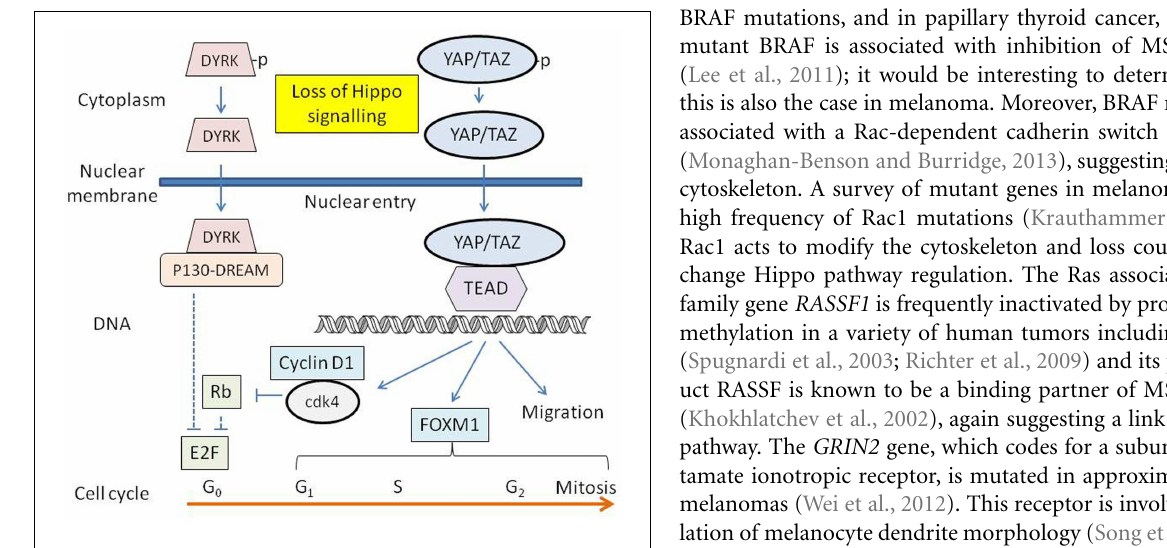
FIGURE 5 |Western blots of whole-cell extracts of cultures of normal melanocytes and of a number of melanoma lines, indicating expression ofYAP andTAZ .The numbers indicate the identities of members of the New Zealand melanoma collection (e.g., 3 = NZM3). Mel indicates data for normal